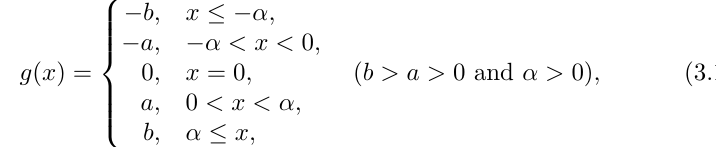
Figure 1. Simple step functions: a) sigmoid function g ( x ) = 2